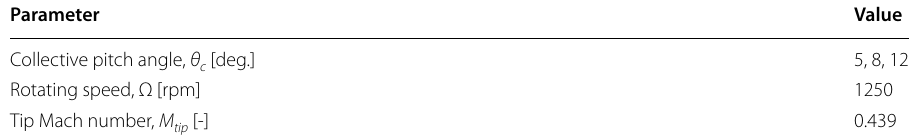
Table 4 Flow conditions for Caradonna-Tung rotor simulation Parameter